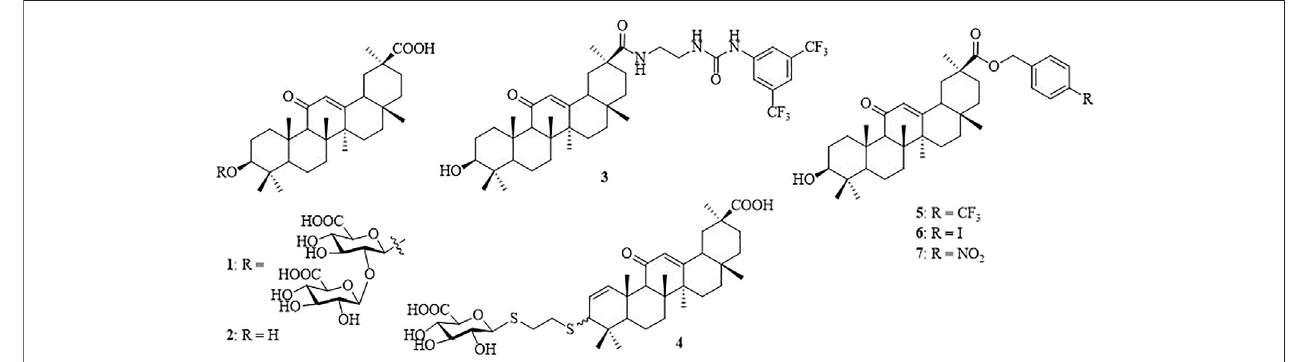
FIGURE 1 | Chemical structures of glycyrrhizic acid ( 1 ), GA ( 2 ), and its derivatives ( 3 – 7